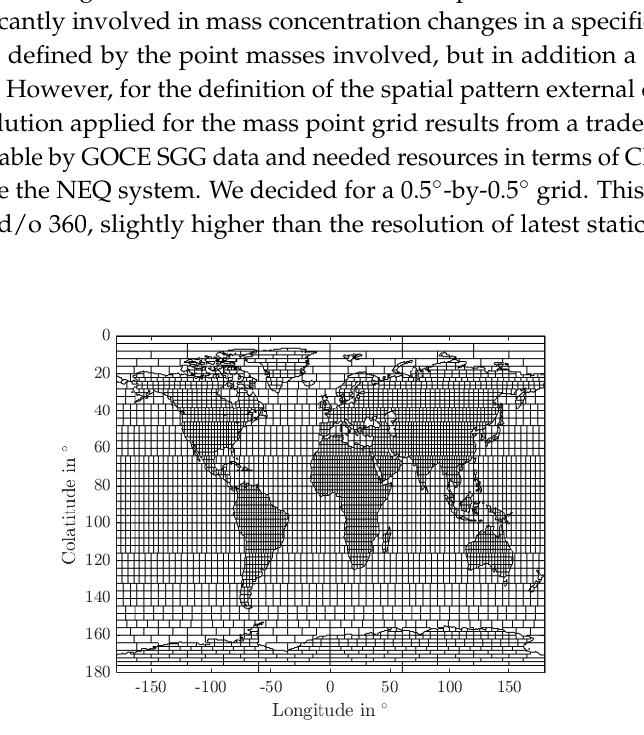
Figure 6. Spatial grid used to compute the mascon gravity field solutions. The resolution is approximately 2 ◦ above the land and 4 ◦ above the ocean, while land and ocean areas are separated by a land-sea